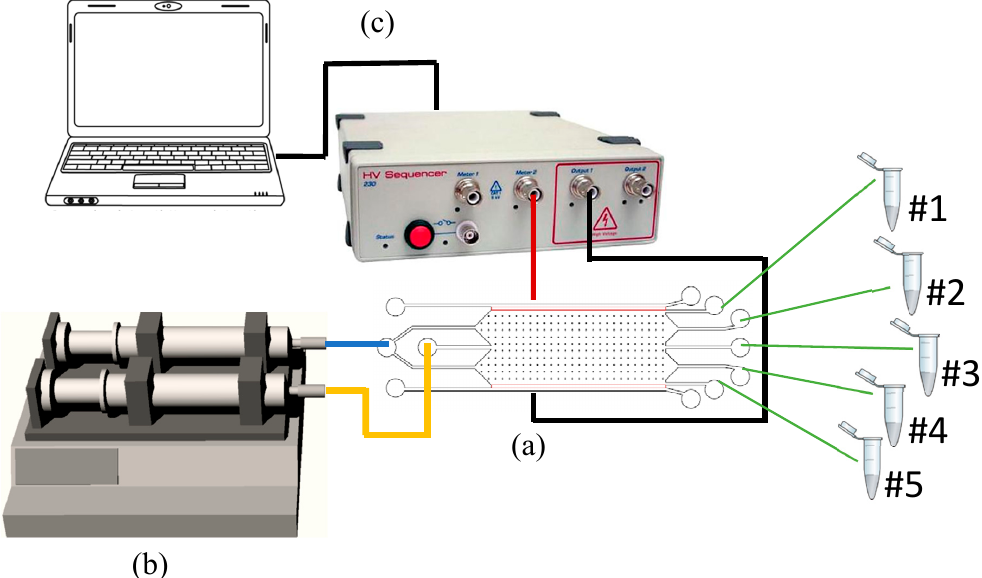
Figure 3. Experimental setup: ( a ) µFFE device sketch in which the yellow line indicates the solution containing the analyte, the blue one the buffer solution, red is the +V and black the ground electrode, the green lines are the sample outlets; ( b ) the syringe pump system and ( c ) the power supply.